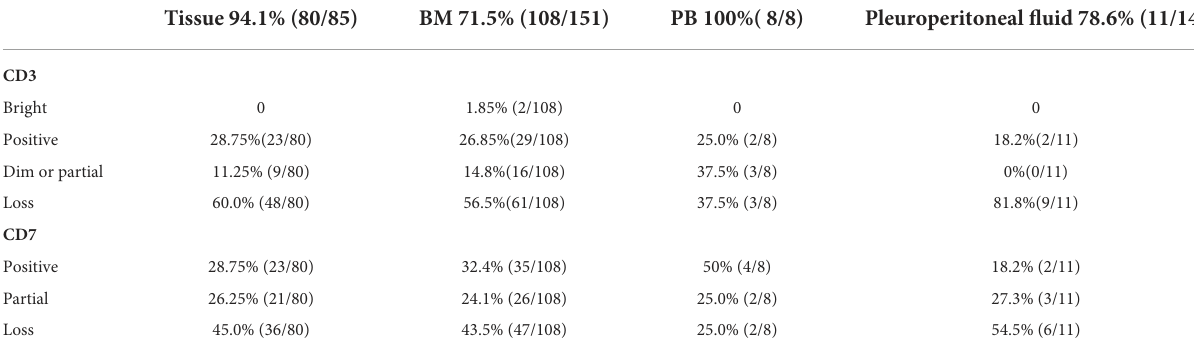
TABLE 2 The expression of CD3 and CD7 in different